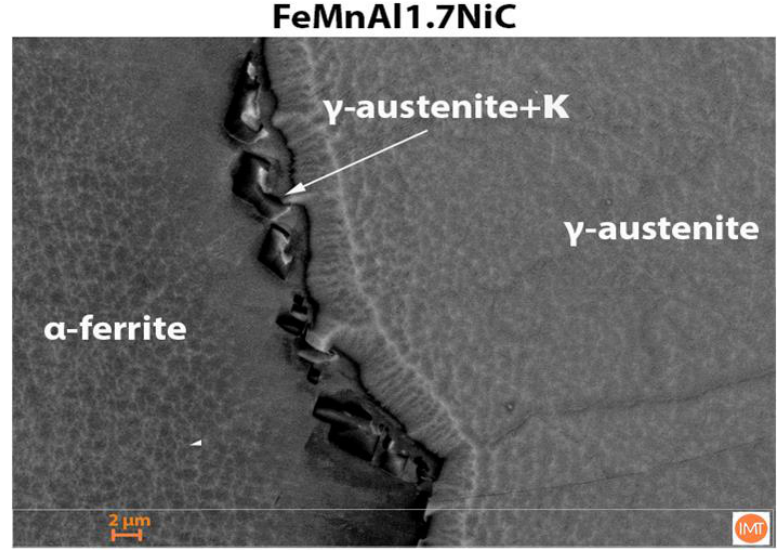
Figure 6. Fe-Mn-Al-1.7Ni-C steel microstructure with the BCC/FCC phase boundary.